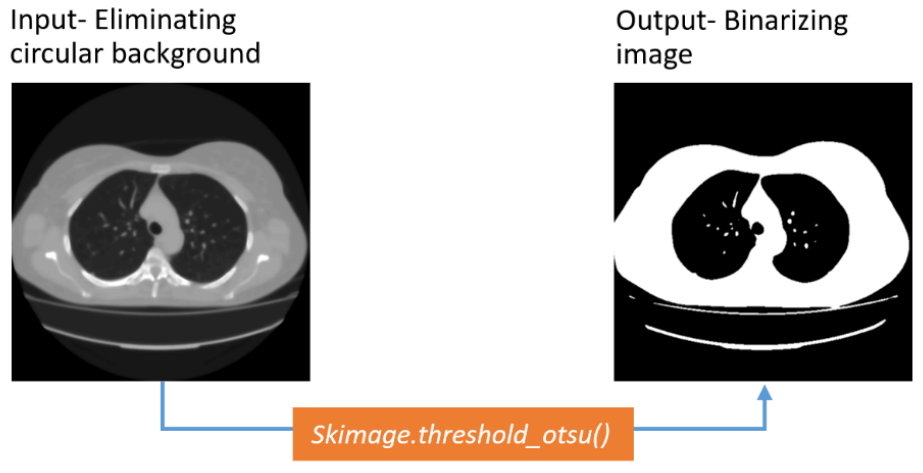
Figure 12. Output of Otsu thresholding. Largest Contour